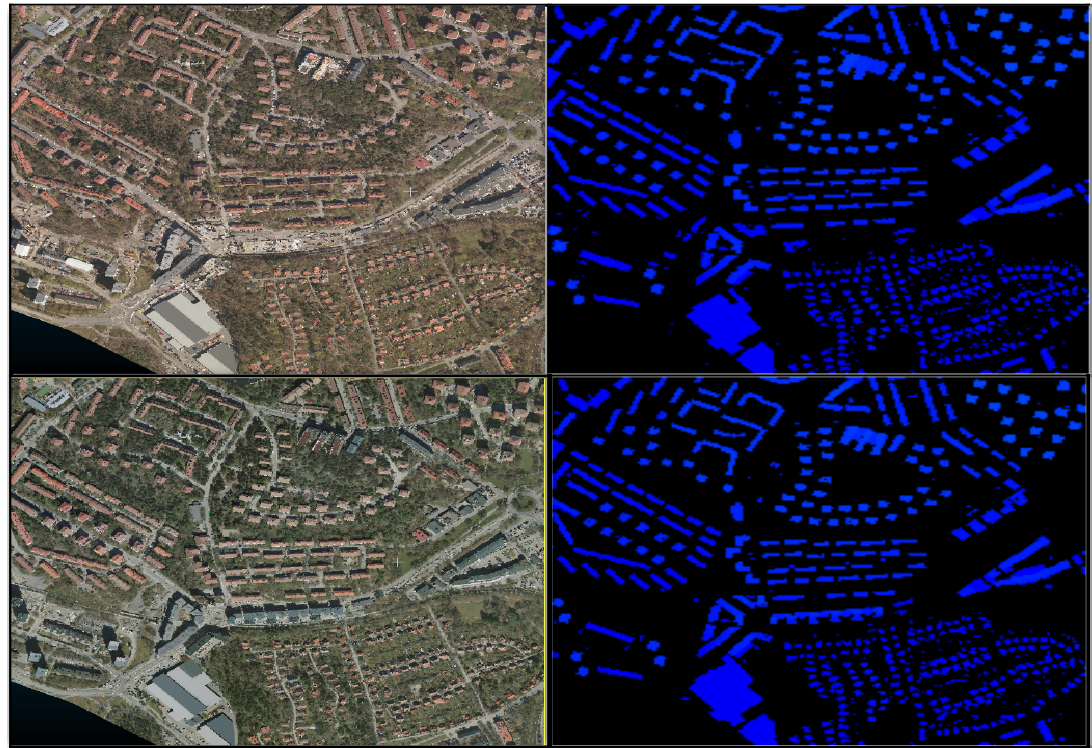
Figure 1. Data Sample Visualization. From left to right, we have RGB image which is the orthophoto projection on LiDAR point cloud, second is Ground truth used for the Building Segmentation task. First row is showing data from year 2017 and second from